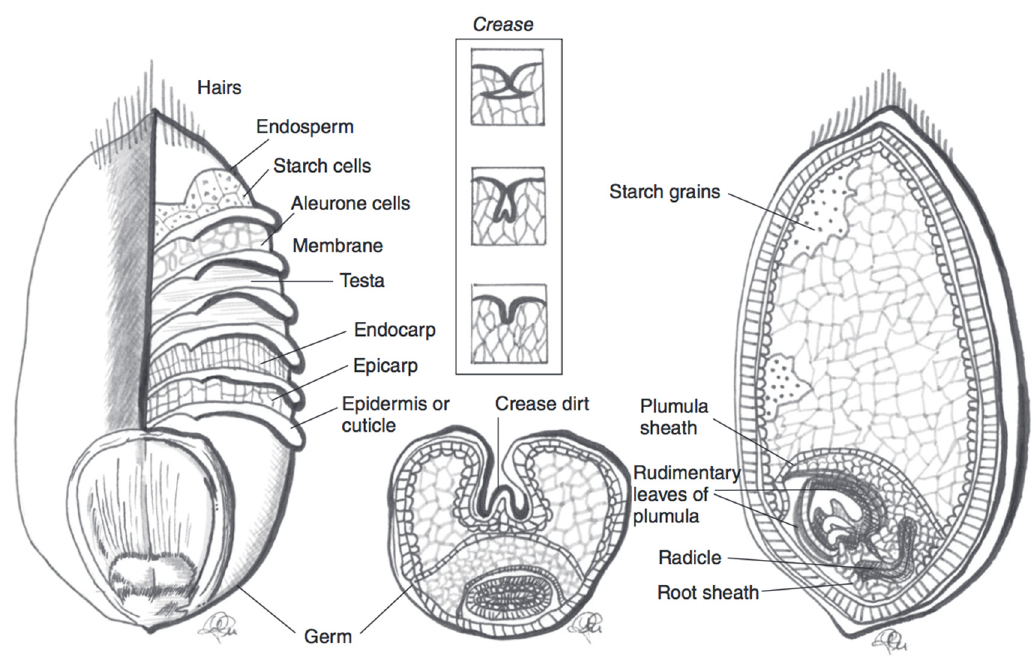
Figure 2. Schematic representation of a wheat kernel cross-section, with component parts. The pericarp is represented by the endocarp and esocarp in this illustration. Adapted from reference [27].